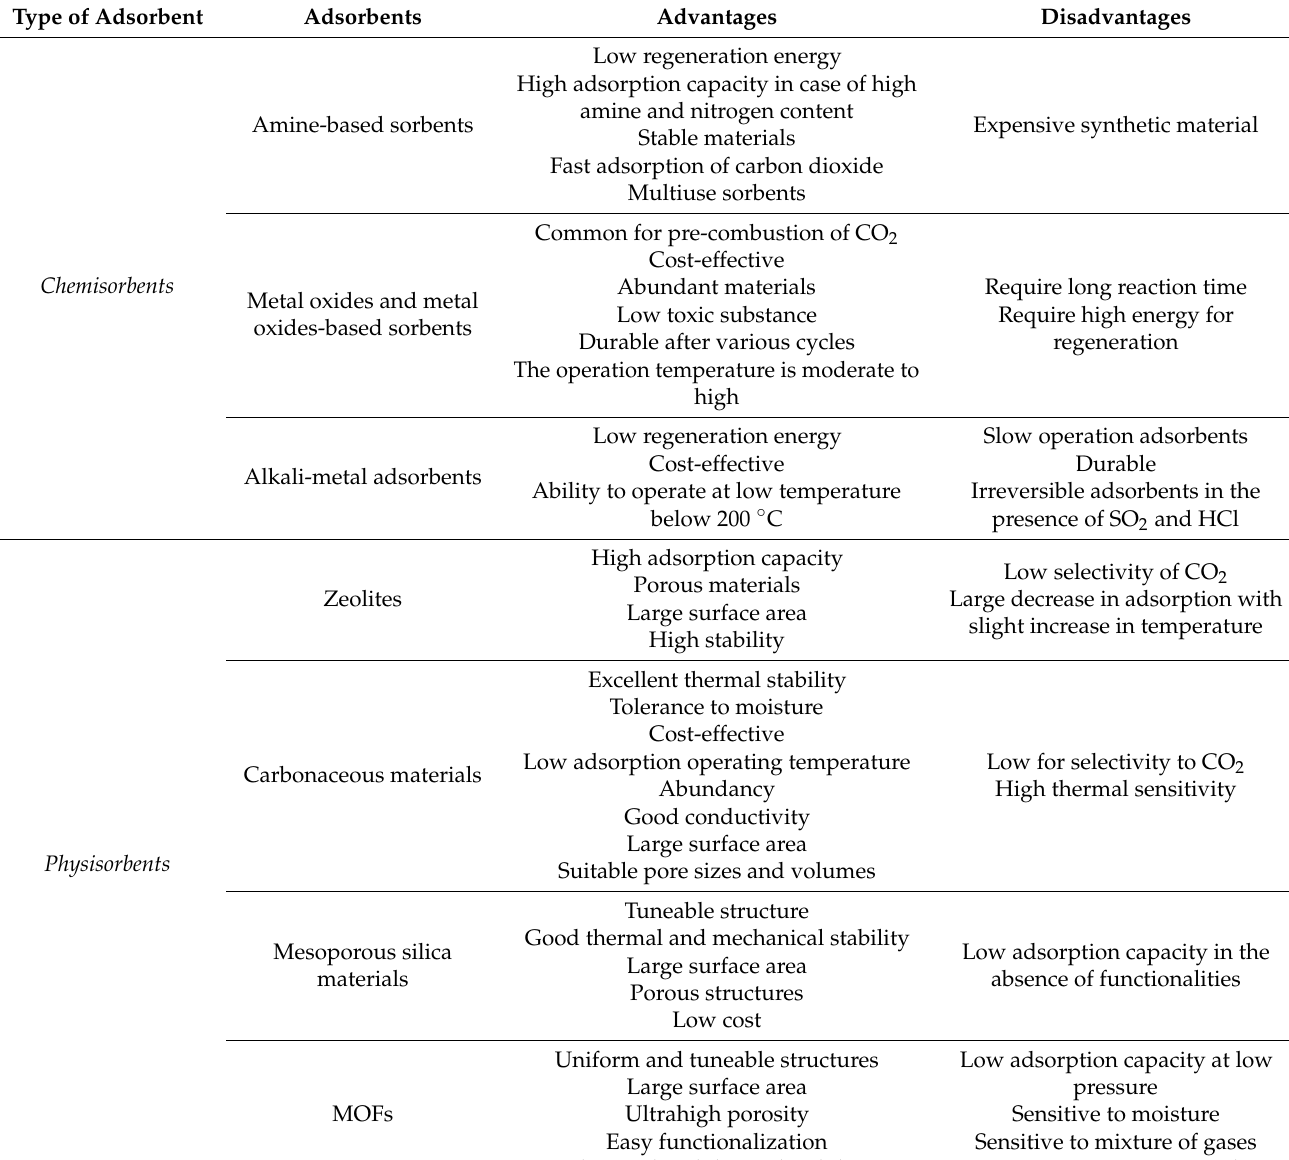
Table 2. Pros and cons of different types of carbon dioxide